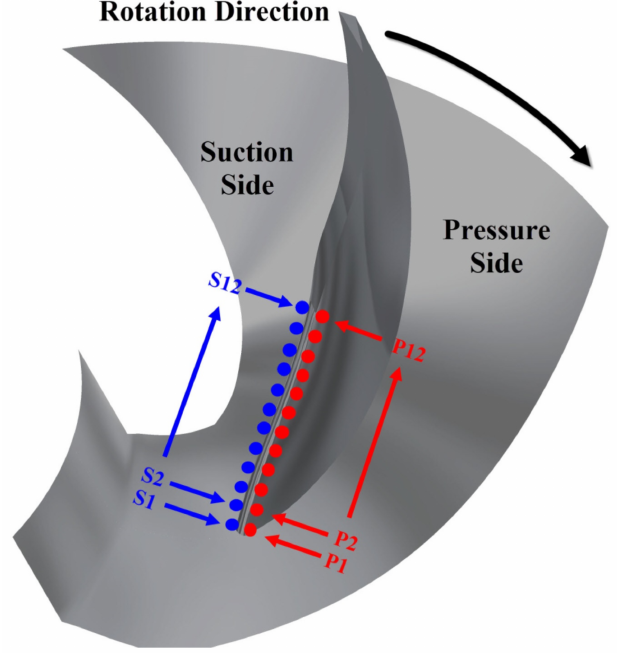
Figure 2. The monitoring points’ location.